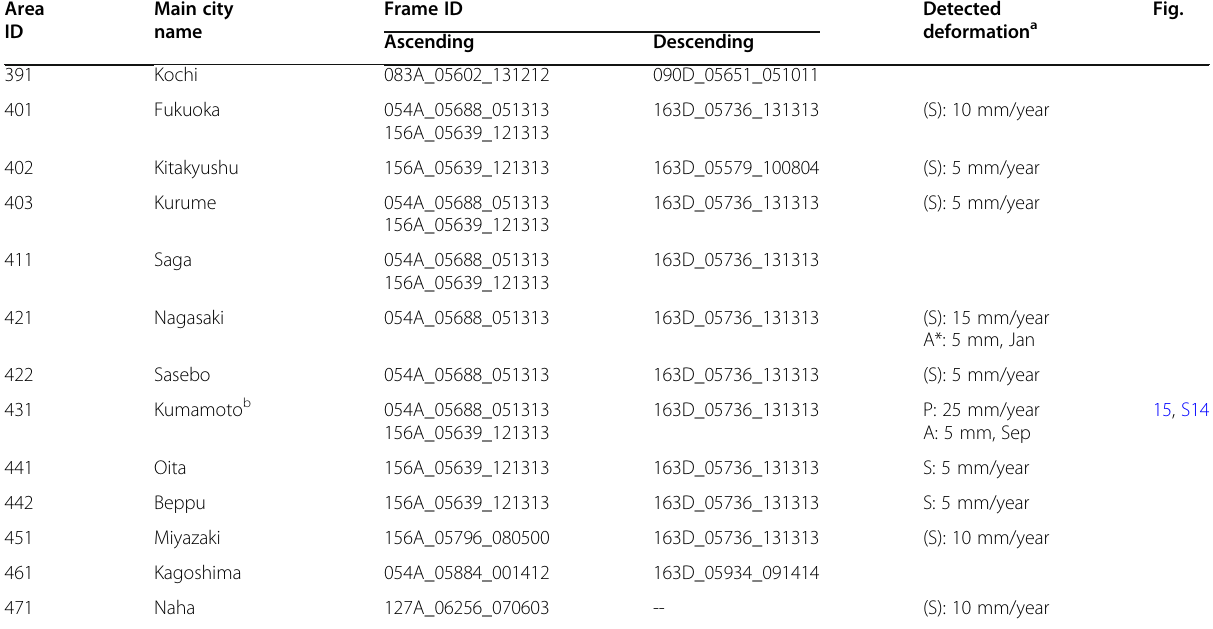
Table 2 Target urban areas, corresponding frame ID, and detected deformation signals